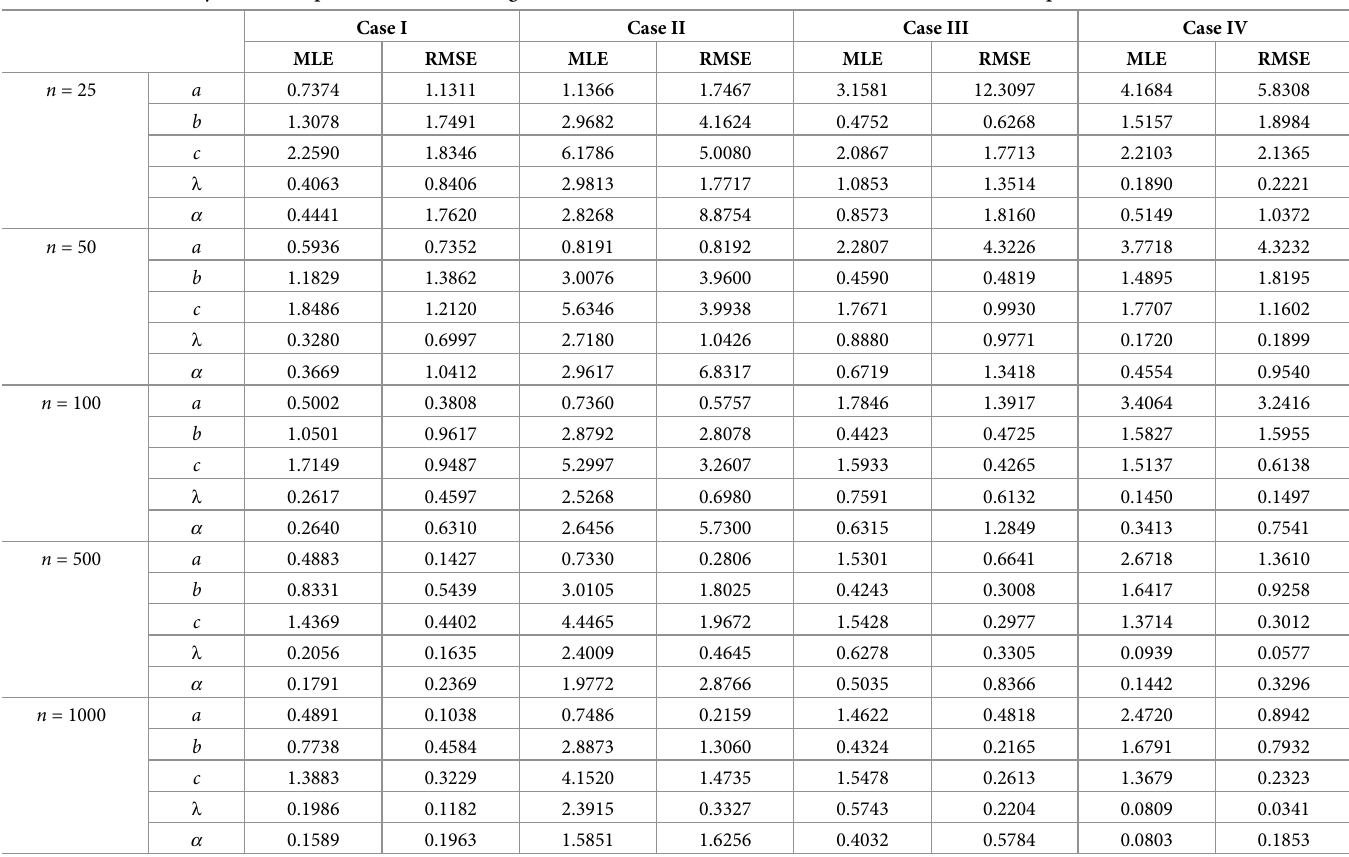
Table 2. Simulation study: APKumW parameter estimates, together with the RMSE for three different cases with different sample